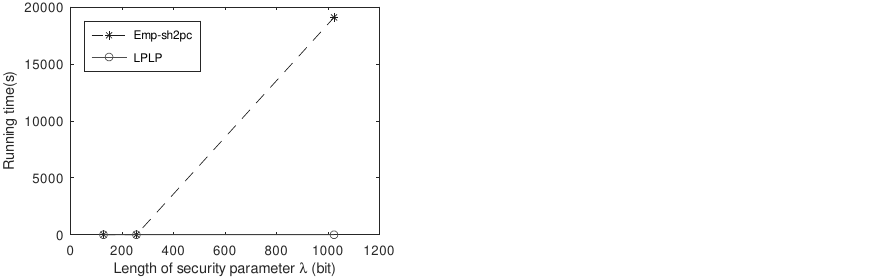
Figure 4. The running time comparison of multiplicative operation between LPCP and Emp-sh2pc.